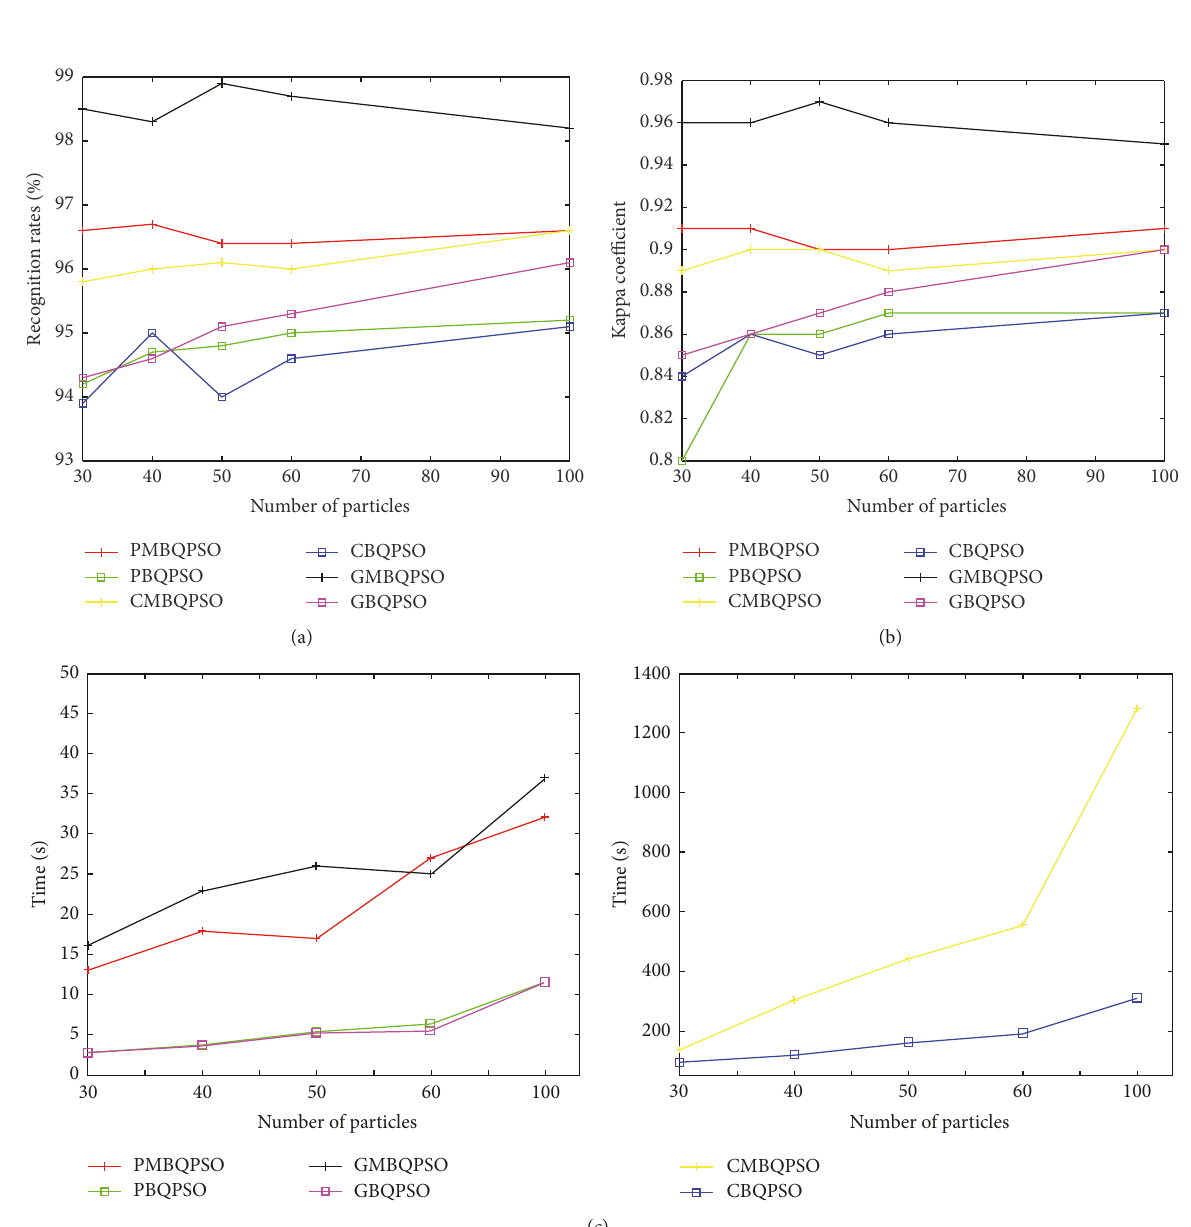
Figure 7: Comparison of different particle number: (a) recognition rates curve with particle number, (b) Kappa coefficient curve with particle number, and (c) iteration time curve with particle